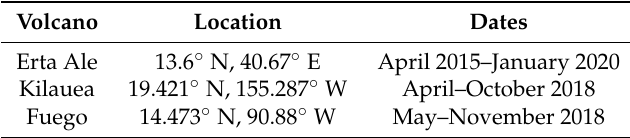
Table 1. Eruption events considered in this work. Locations are taken from the database maintained by the Smithsonian Institution Global Volcanism Program